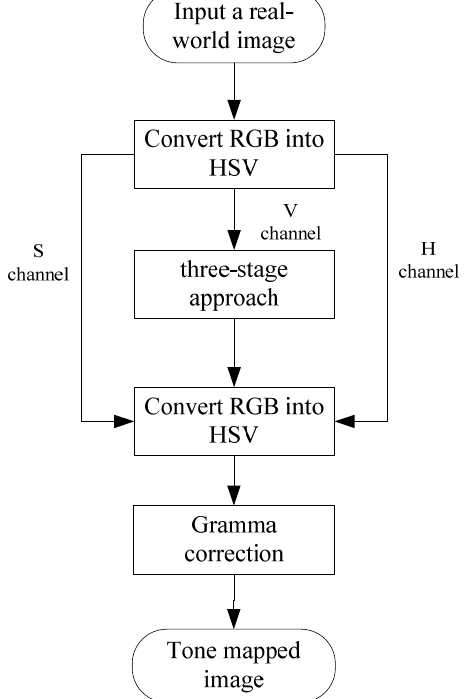
Figure 5. Data flow diagram for dealing with a color image. Three channels are separated into H, S, and V channels, where the V channel is only used to compress dynamic range, and the H and S channels are constant. The last part is Gamma correction, which is used for overcoming the non-linear response of the display device.